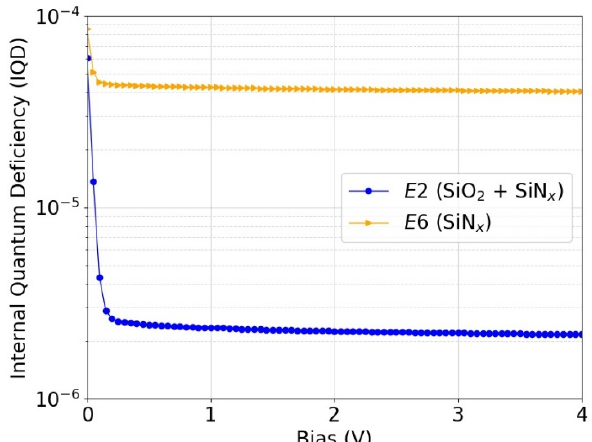
Figure 12. Simulated IQD as a function of reverse bias voltage for p-type inversion-layer photodiode that would be fabricated with passivation E2 (6 nm SiO 2 + 65 nm SiN x ) and E6 (65 nm SiN x ) as described in Table 1. The simulations were performed at a wavelength of 488 nm.